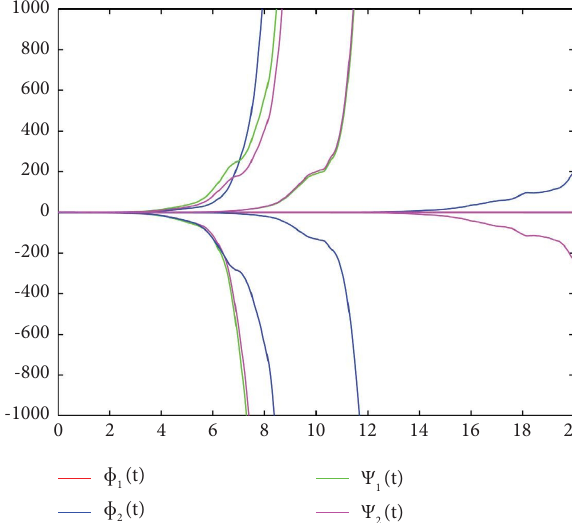
Figure 3: Te state of system (81) with T � 0 . 006, Y 􏽮 􏽯 � 2 ξ + 1/210. and Θ ξ